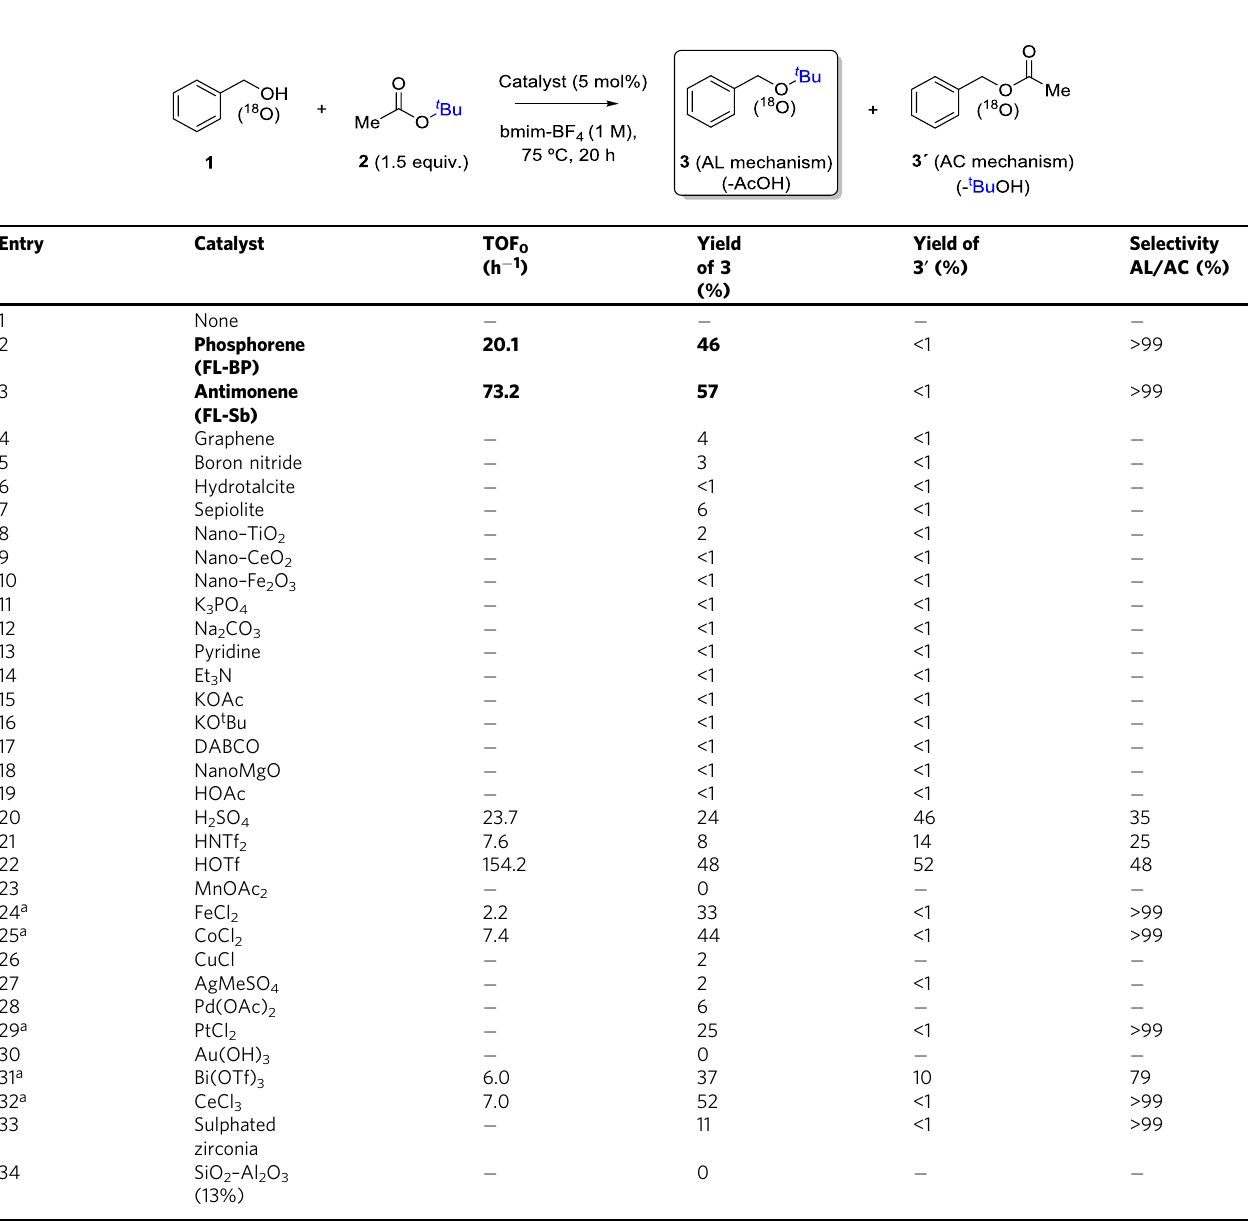
Table 1 Results for the catalytic alkylation of 1 with 2. Conversion of 1 is the sum of 3 and 3 ʹ yields, the rest is unreacted